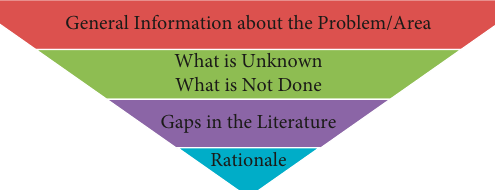
Figure 6: Funnel-down scheme followed while writing the in- troduction section of manuscript, moving from broader to specific